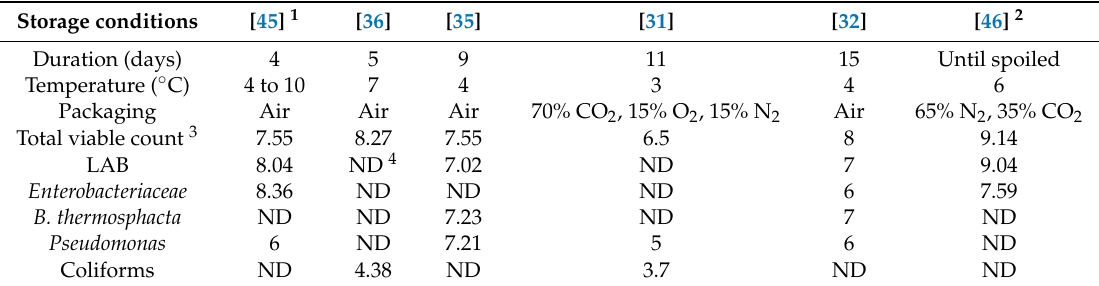
Table 2. Enumeration of bacteria from spoiled chicken meat. Storage conditions and values of bacterial counts have been collected from different